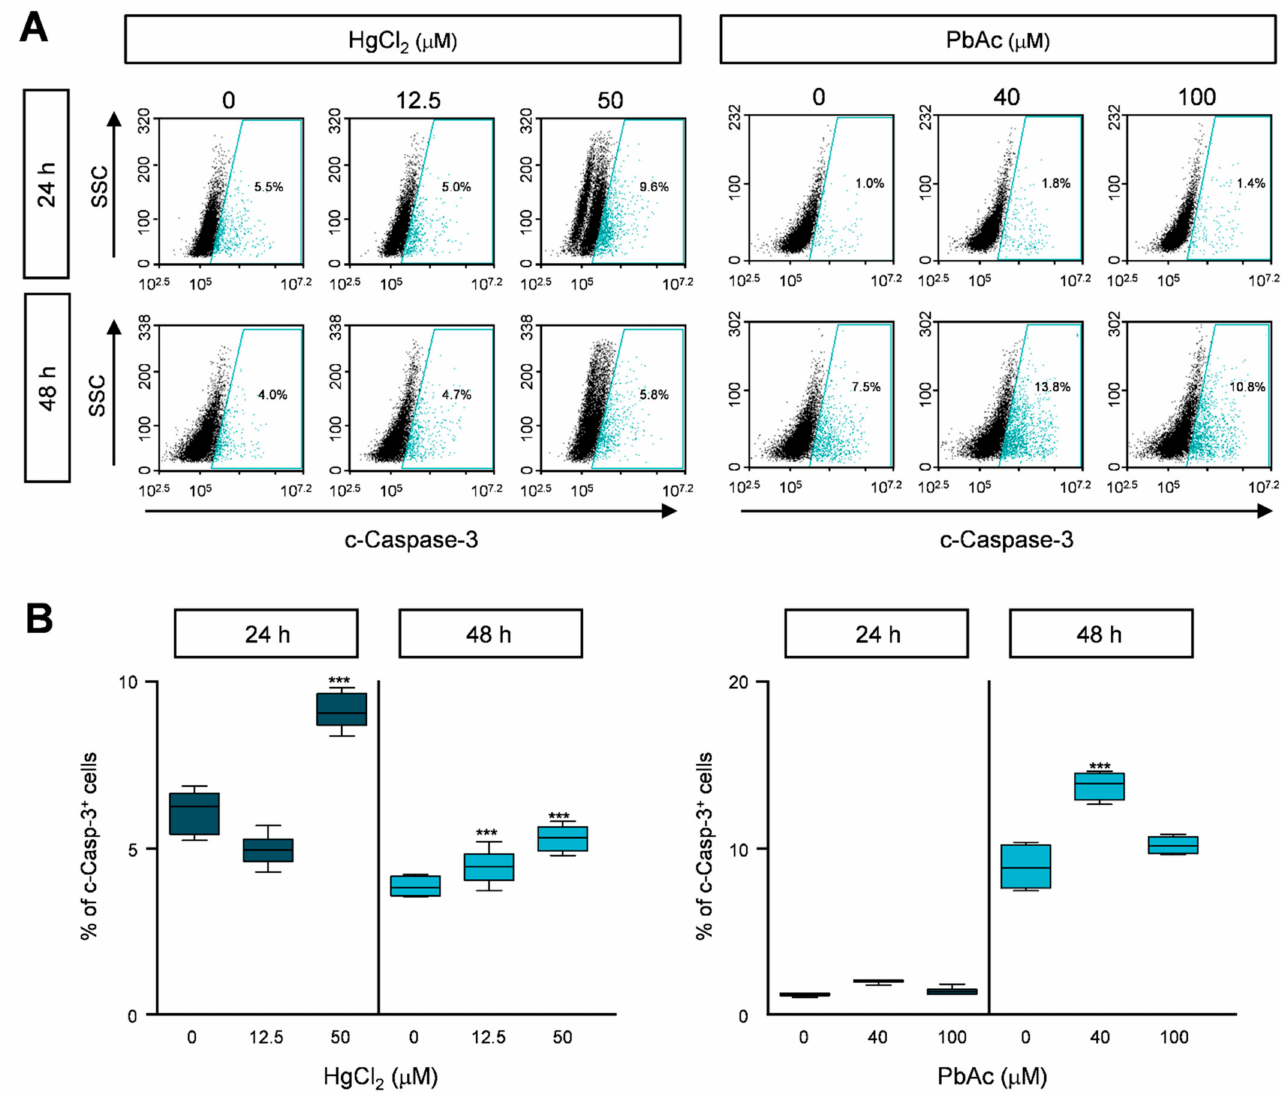
Figure 7. The effect of caspase-3 activity in heavy metals-treated MRC5 cells. ( A ) Cells were treated with indicated concentration of heavy metals for 24 or 48 h. Cells were fixed with 1% PFA and stained with anti-cleaved caspase-3 antibody. Expression levels of cleaved caspase-3 were analyzed by FACS analysis. ( B ) The percentages of cleaved caspase-3-positive cells are represented as the mean ± S.E.M. of three independent experiments (n = 6), each performed in triplicate. EtOH was used as the negative control. Error bars show mean ± SEM. p values obtained by Student’s t -test. *** p value <